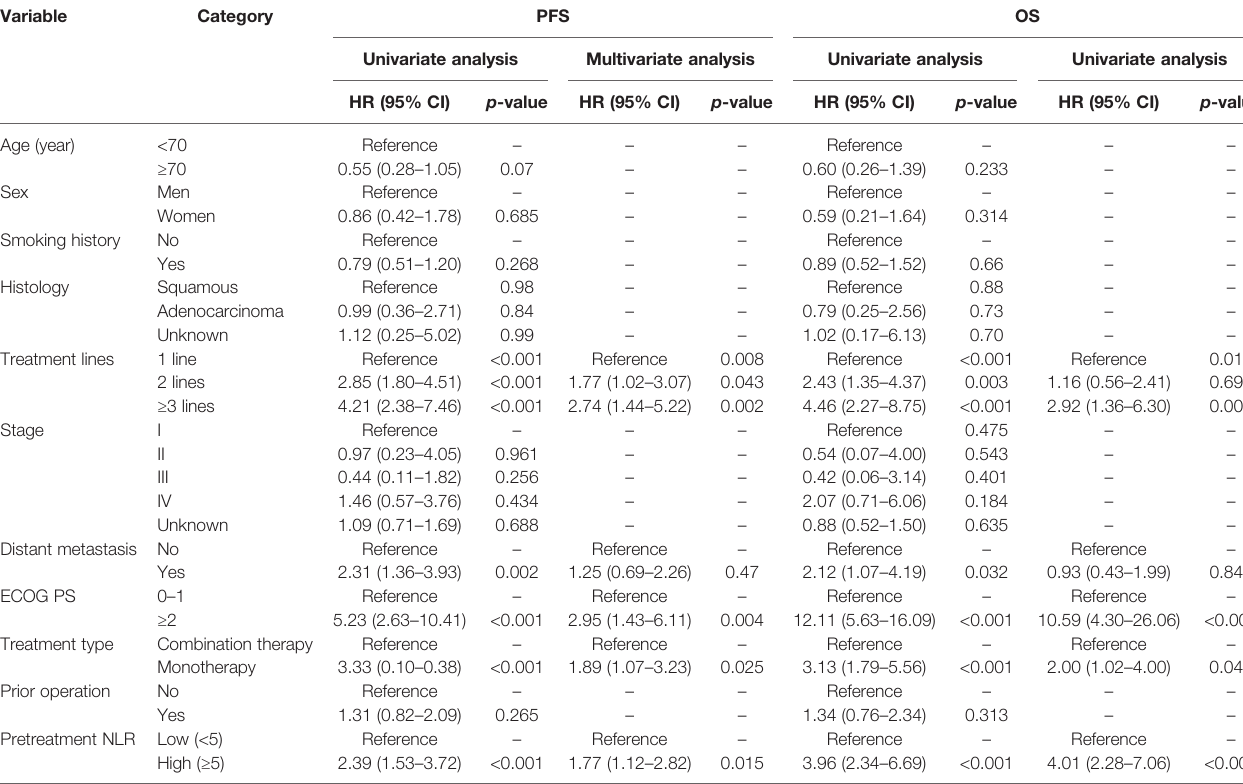
TABLE 3 | Univariate and multivariate analyses for PFS and